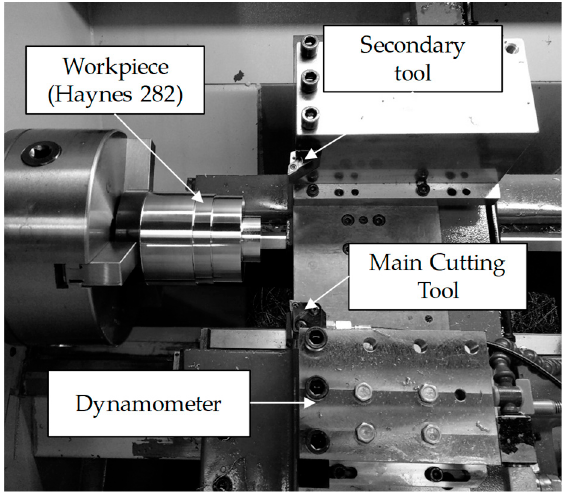
Figure 1. Instrumentation and setup.